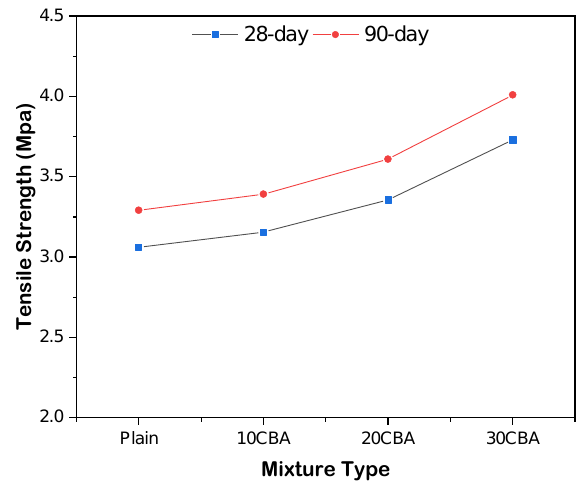
Figure 9. Tensile Strength of concrete mixed with CBA.